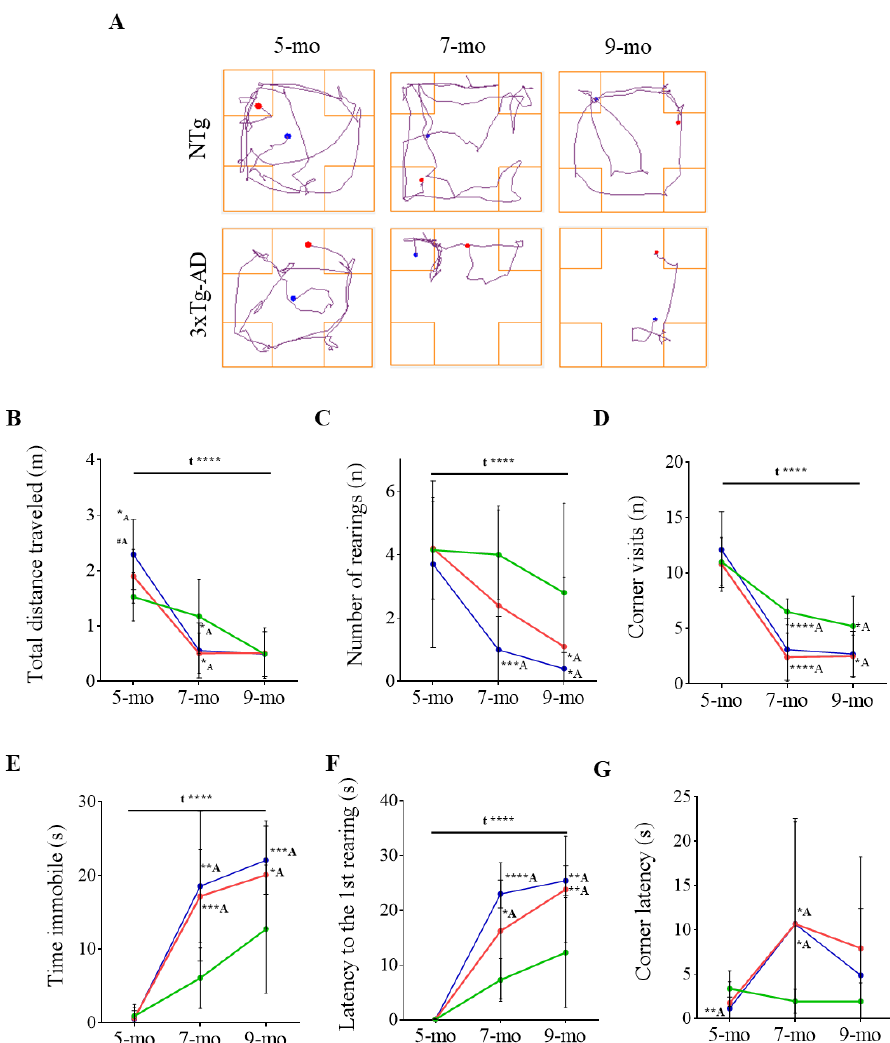
Figure 2. Behavioral and psychological symptoms of dementia (BPSD)-like symptoms as tested in the corner test. ( A ) Track plots of the pathway followed by PBS-treated NTg and 3xTg-AD representative animals. The blue point indicates the animal location at the starting point and the red point the final location. ( B – F ) Evolution of NTg (green), 3xTg-AD (red), and scFv-h3D6-treated 3xTg-AD (blue) mice with age considering ( B ) the distance travelled (m), ( C ) number of rearings, ( D ) number of corner visits, ( E ) immobility time (s), ( F ) latency to the first rearing (s), and ( G ) latency to the first corner visit (s). Values are represented by means and error bands correspond to SD. # indicates a low, but not significant, p -value (0.05 < p ≤ 0.1) (Total distance travelled (m), 5-mo, NTg vs. 3xTg-AD-PBS, t = 2.022, p = 0.0583* significant differences p ≤ 0.05, ** p ≤ 0.01, *** p ≤ 0.001, **** p ≤ 0.0001. A refers to NTg mice.